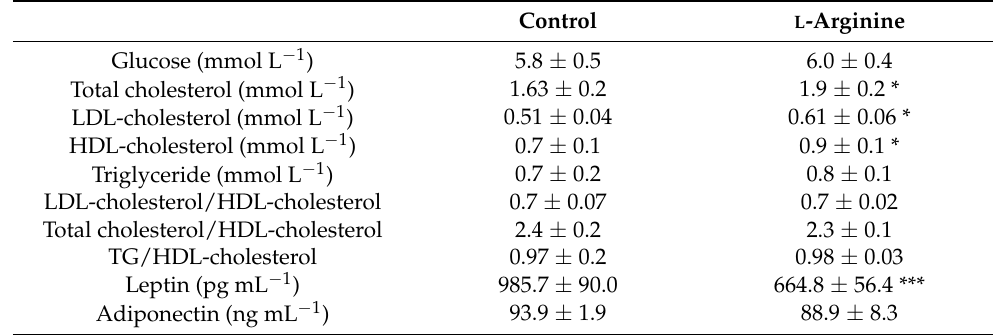
Table 1. Effects of L -arginine on blood glucose and serum leptin, adiponectin, total, HDL-, LDL- cholesterol, and triglyceride levels; 2.5-month-old rats were randomly assigned to receive drinking water or 2.25% L -arginine-HCl in drinking water for 7 days.